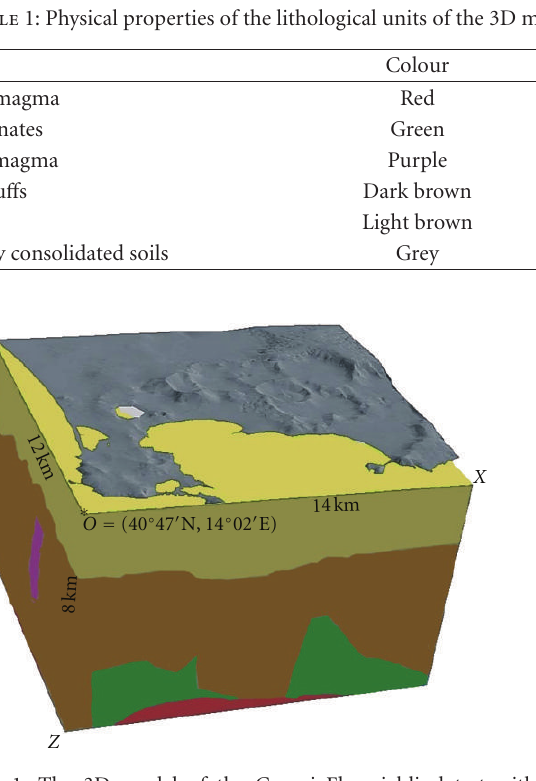
Figure 1: The 3D model of the Campi Flegrei blind test with evidence of the surface topography and the main lithological units. See Table 1 for the description of the lithological